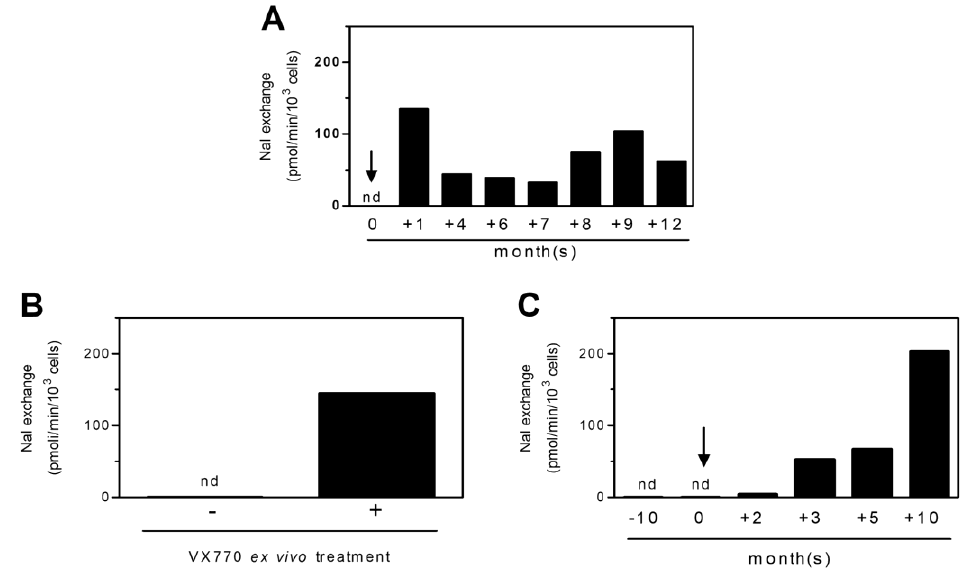
Figure 2. Monitoring CFTR activity following VX770 ex vivo and in vivo treatments: ( A ) CFTR activity was monitored in PBMCs freshly isolated from a CF patient carrying CFTR G1349D and F508del mutations, before (0 month) and after Ivacaftor oral therapy (+1, +4, +6, +7, +8, +9, and +12 months). nd, not detectable; ( B ) PBMCs freshly isolated from another CF patient carrying CFTR G1349D and F508del mutations were cultured in the absence (–) or in the presence (+) of 5 µ M VX770. After 24 h, CFTR activity was assayed. nd, not detectable; ( C ) CFTR activity was monitored in PBMCs freshly isolated from the CF patient before (–10 and 0 months) and after Ivacaftor oral therapy (+2, +3, +5, and +10 months). nd, not detectable. The arrows indicate the beginning of the therapy.